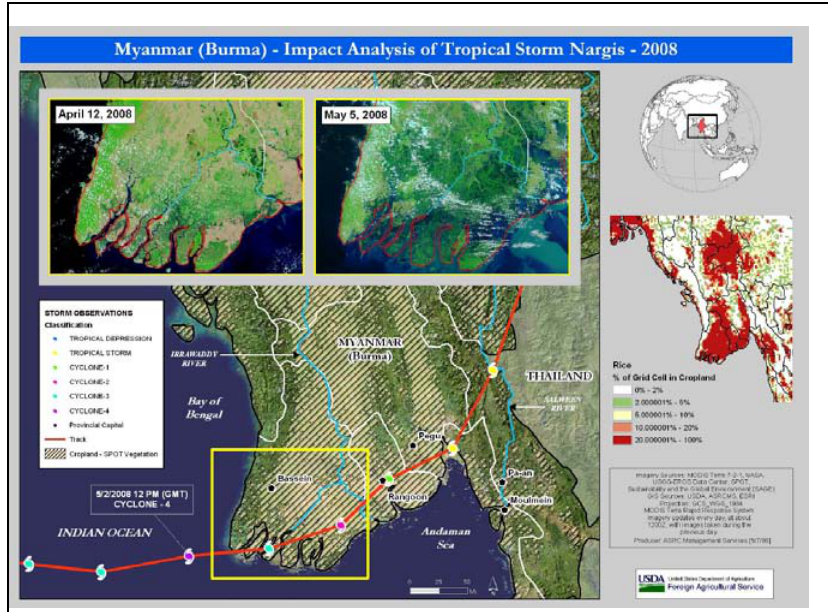
Figure 3. Using MODIS Rapid Response Imagery to Assess Impact of Tropical Storm Nargis,